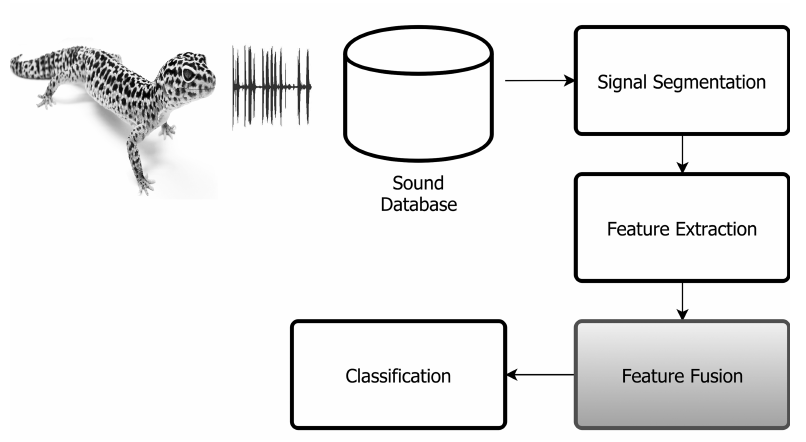
Figure 1. Automatic acoustic classification system